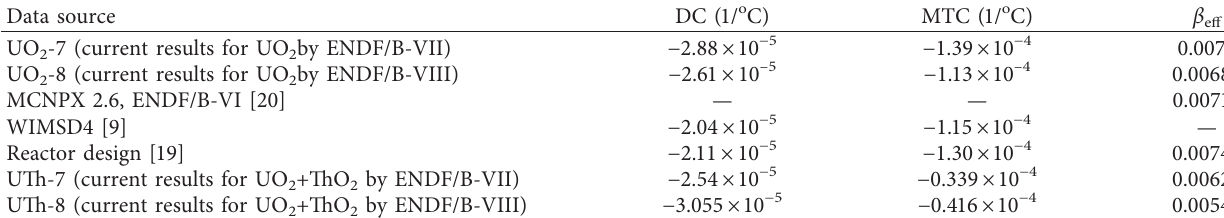
Table 4: Comparison between current calculated parameters with references [9, 19, 20].